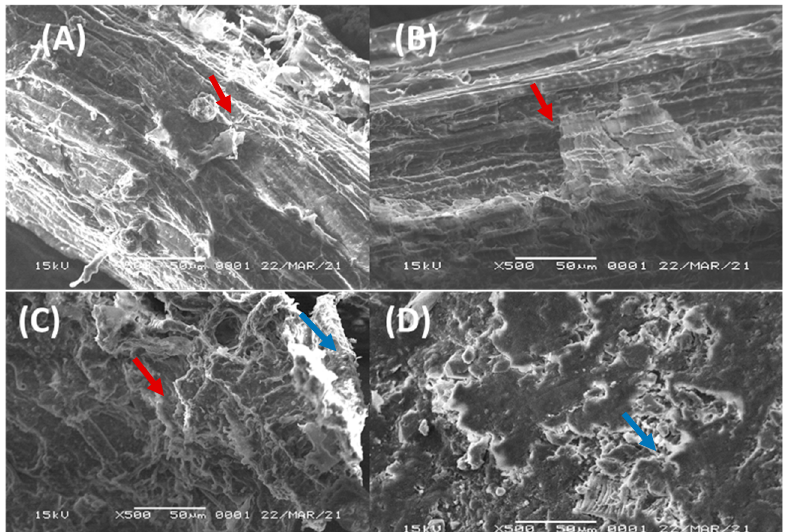
Figure 4. Scanning electron microscope images. Fresh OPEFB ( A ), after xylanase hydrolysis ( B ), after cellulase hydrolysis ( C ), after ethanol semi-SSF process ( D ). Lignin (red arrow), silica (blue arrow).